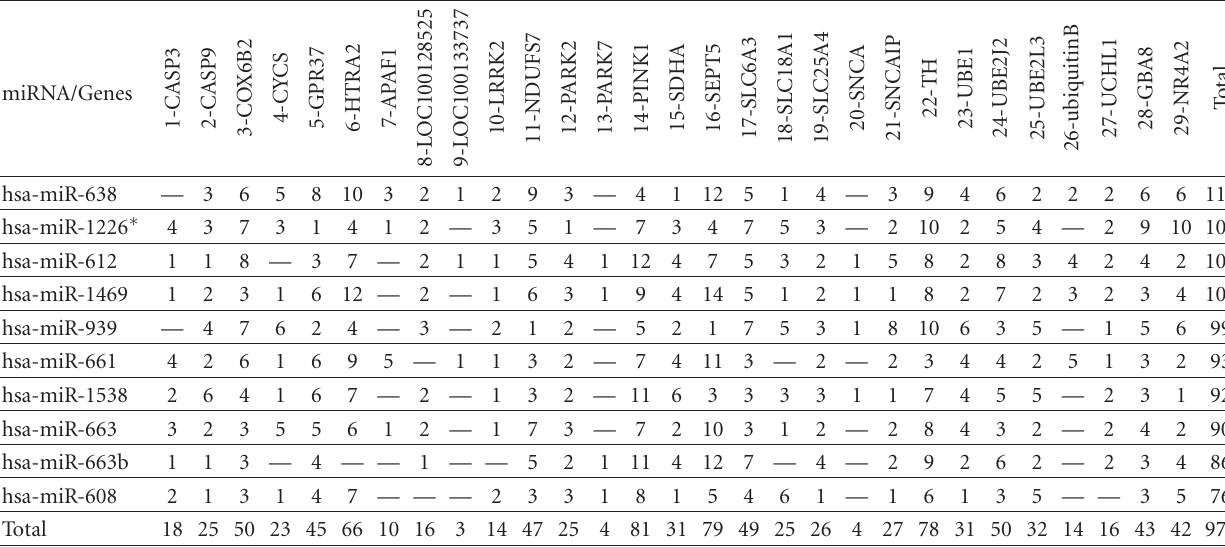
Table 1: Multiplicity and cooperativity for all miRNA